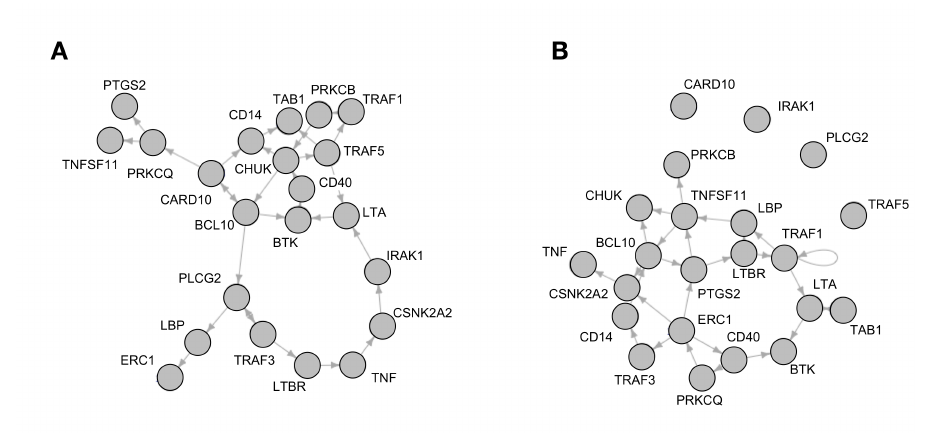
Figure 2. Network wiring of reconstructed Boolean networks, showing one of the possible combinations of the reconstructed functions which were drawn. ( A ) shows a network representing the young phenotype and ( B ) the aged